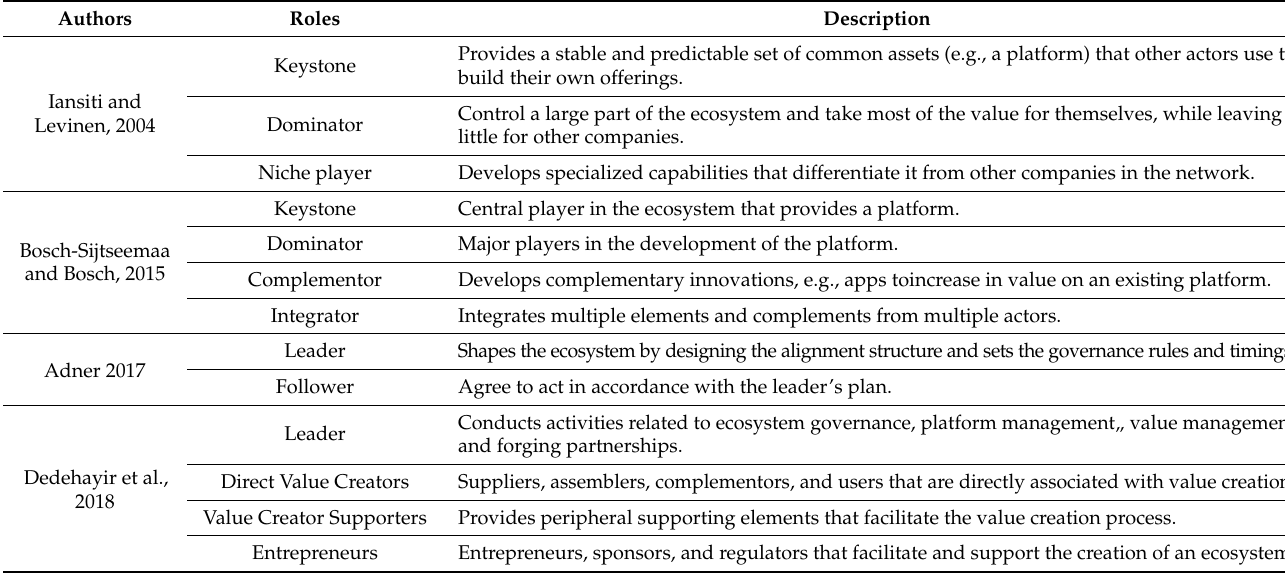
Table 1. Role of stakeholders in the